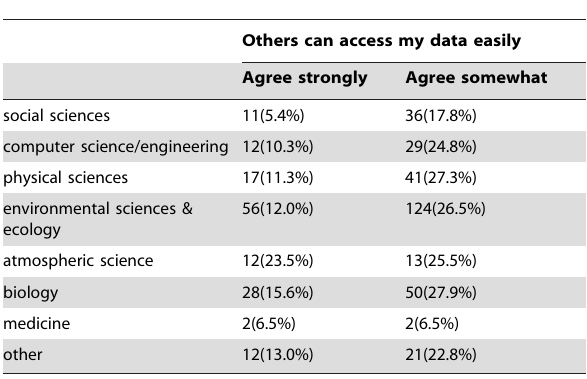
Table 16. Data sharing by subject